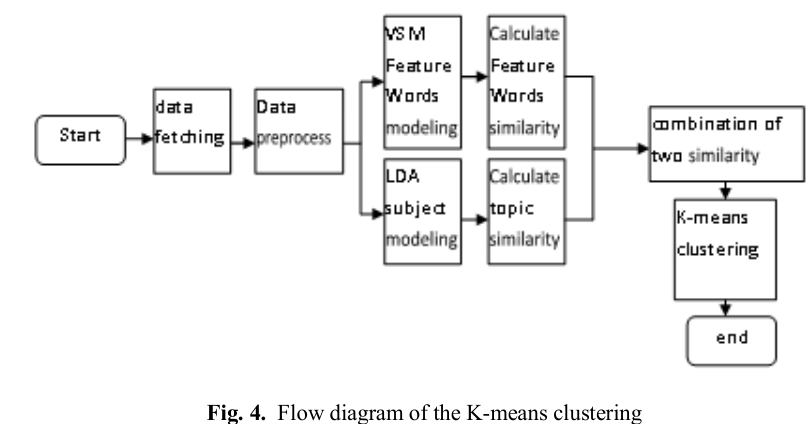
Fig. 4. Flow diagram of the K-means